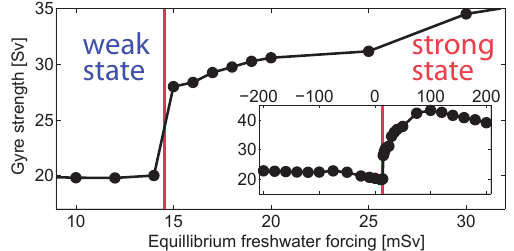
Fig. 1. Equilibrium threshold behaviour of Atlantic SPG volume transport in response to constant surface freshwater flux. The SPG exhibits a threshold behaviour at 15mSv freshwater forcing strength where it intensifies by more than 40%. The inlay shows its response in the entire forcing interval of ±